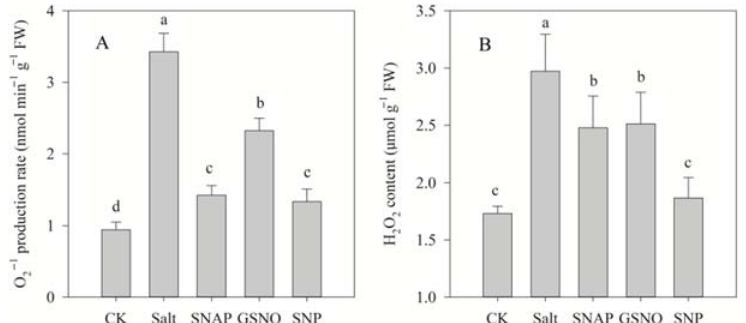
Figure 1. Superoxide radical (O 2 − ) production rates ( A ) and H 2 O 2 content ( B ) of C. paliurus seedlings under different treatments. CK (control, distilled water), salt (100 mM NaCl), SNAP (100 mM NaCl with 0.05 mM SNAP), GSNO (100 mM NaCl with 0.05 mM GSNO), SNP (100 mM NaCl with 0.05 mM SNP). Bars represent standard deviation (SD) of the means. Different letters suggest significant differences among the treatments at p < 0.05 (Duncan’s test).